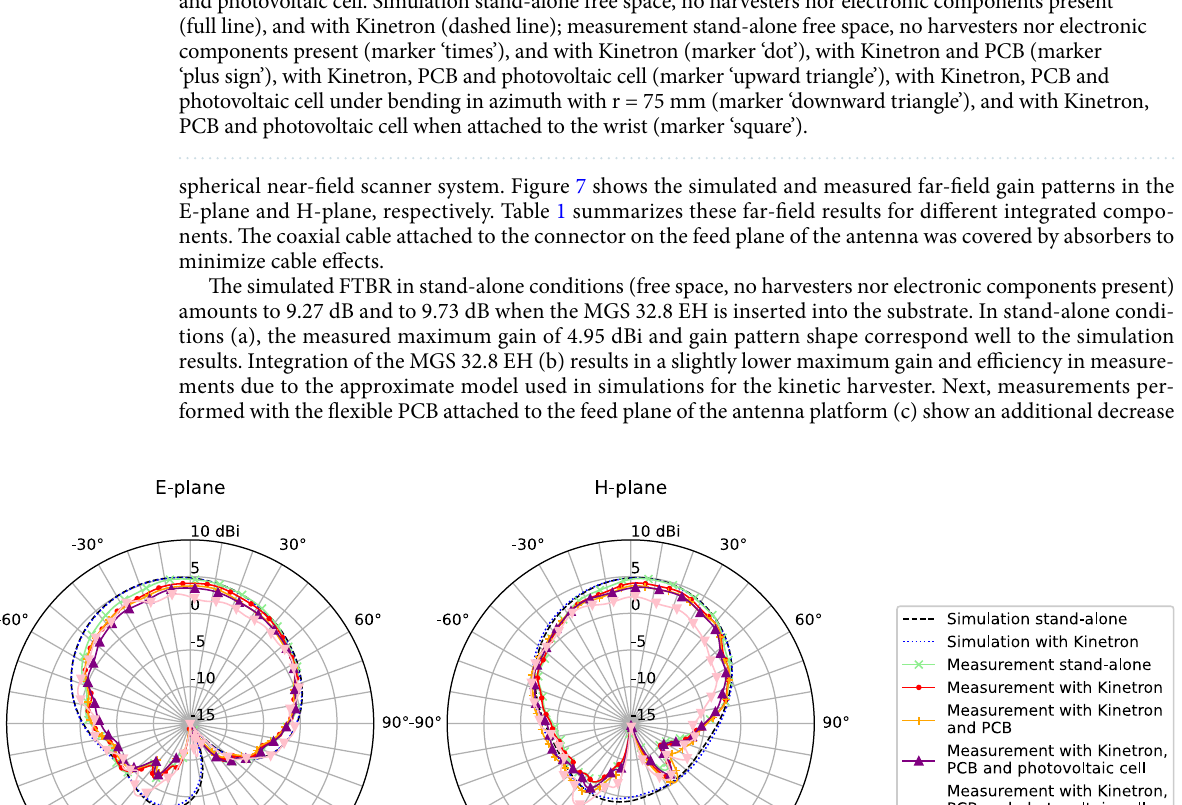
Figure 7. Measured versus simulated radiation pattern at 2.45 GHz, both in E-plane ( φ = 0 ◦ ( φ = 90 ). Simulation stand-alone free space, no harvesters nor electronic components present (dashed line), and with Kinetron (dotted line); measurement stand-alone free space, no harvesters nor electronic components present (marker ‘times’), with Kinetron (marker ‘dot’), with Kinetron and PCB (marker ‘plus sign’), with Kinetron, PCB and photovoltaic cell (marker ‘upward triangle’), and with Kinetron, PCB and photovoltaic cell under bending in azimuth with r = 75 mm (marker ‘downward